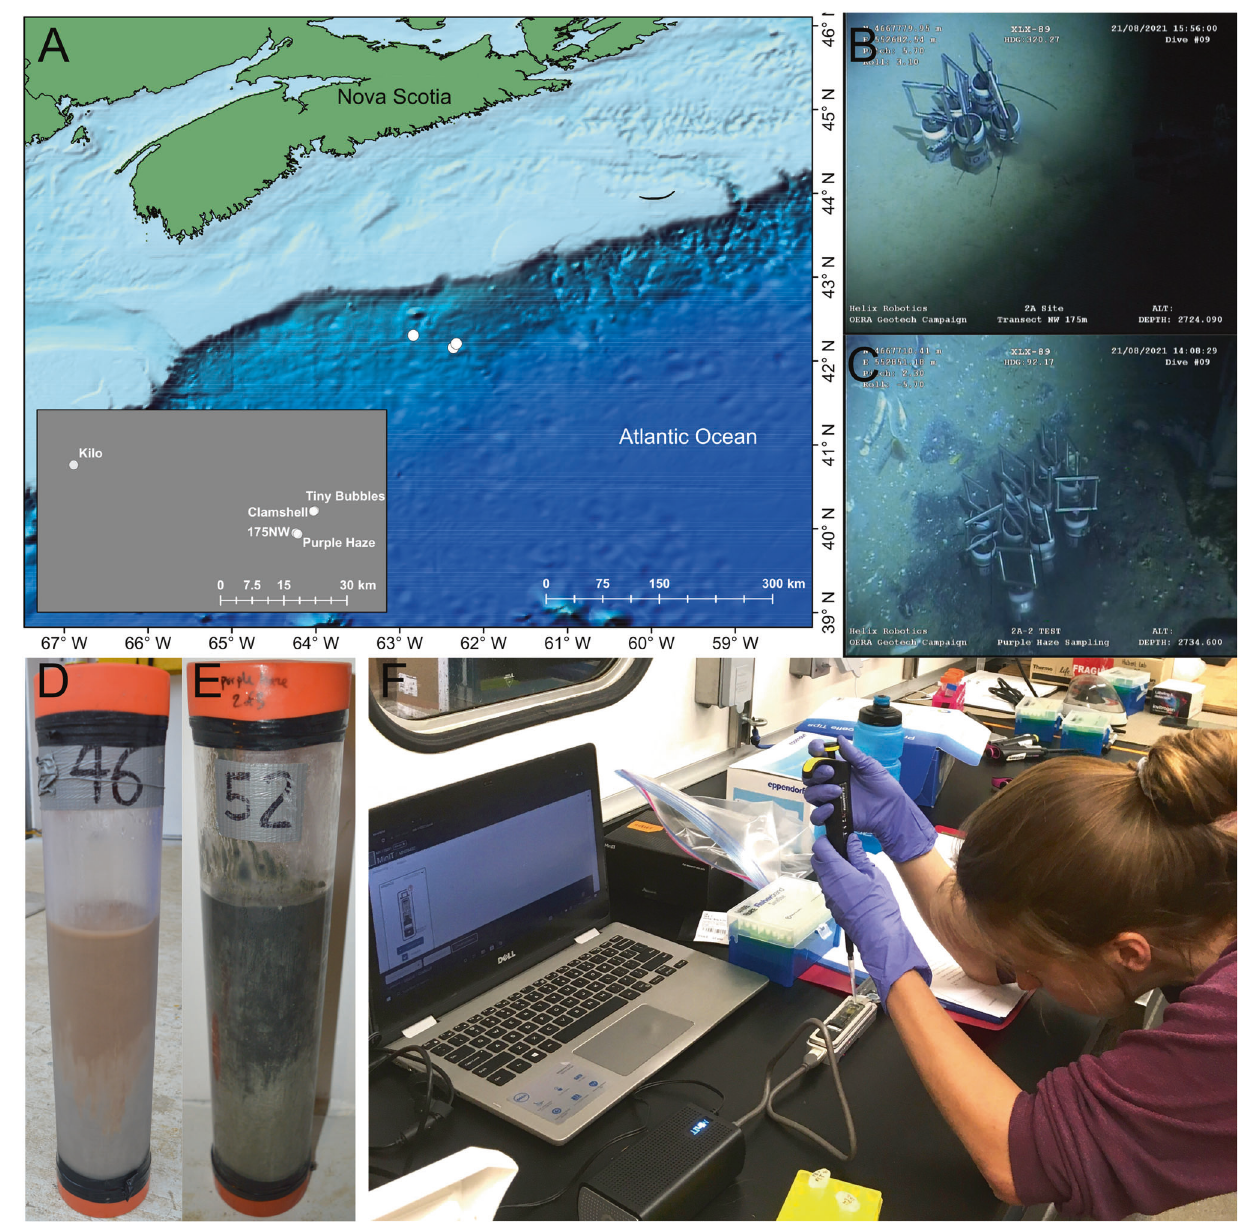
Fig. 1 Research expedition on the Scotian slope offshore Nova Scotia. A Sites sampled in the Northwest Atlantic Ocean. B ROV footage from the background site “ 175NW ” . C ROV footage from the hydrocarbon seep site “ Purple Haze ” . D Image of the 31 cm long core taken from site “ 175NW ” . E Image of the 36 cm long core taken from site “ Purple Haze ” . F A Nanopore MinION sequencing run performed while at sea during the sampling